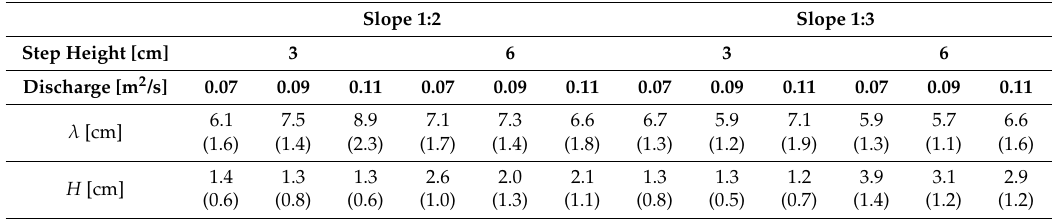
Table 1. Median wavelengths and waveheights extracted from high-speed videos with use of an image processing technique; corresponding median absolute deviations (MAD) given in brackets. Slope 1:2 Slope 1:3 Step Height [cm] 3 6 3